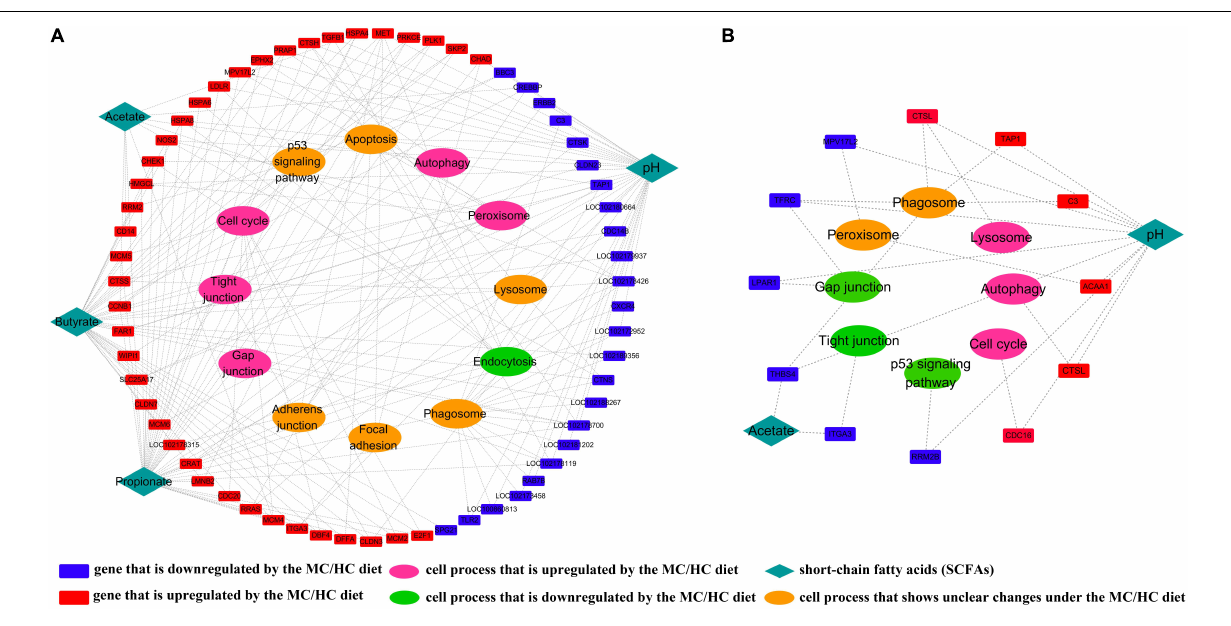
FIGURE 5 | (A) Regulatory effects of ruminal SCFAs and ruminal pH on cellular processes by stimulation of the expression of corresponding genes in the MC group, compared with those in the LC group; (B) regulatory effects of ruminal SCFAs and ruminal pH on cellular processes by stimulation of the expression of corresponding genes in the HC group, compared with those in the MC